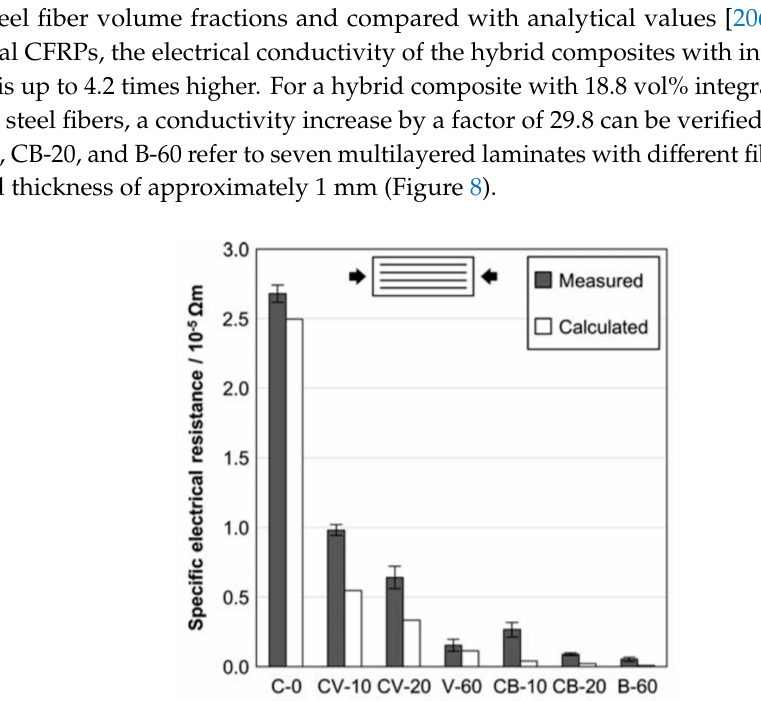
Figure 8. Specific electrical resistance longitudinal to the fiberorientation for di ff erent (hybrid) composites [206]. C = carbon fiber; V = stainless steel fiber; and B = copper cladded low carbon steel